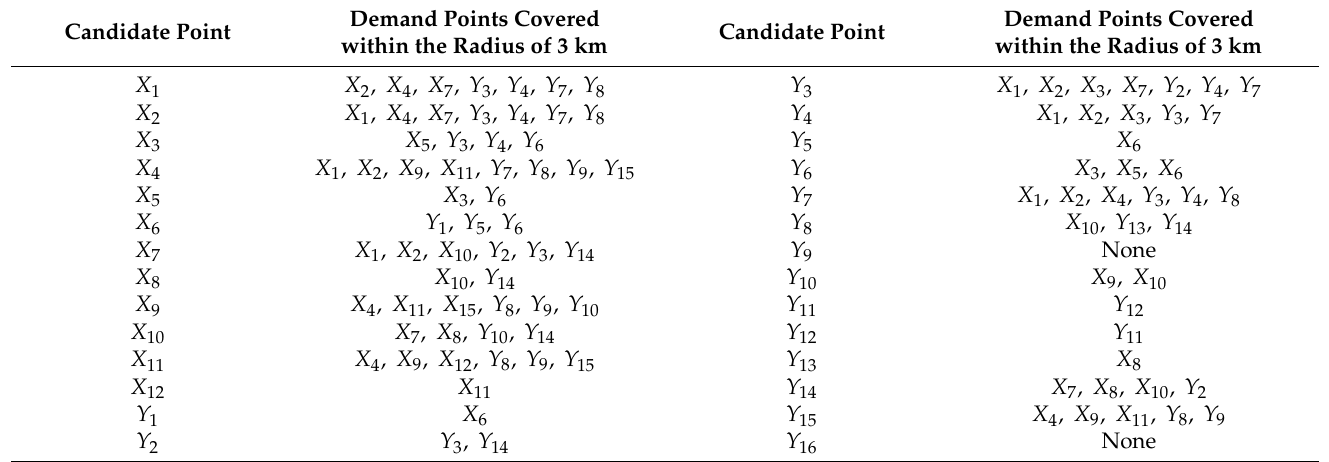
Table 9. Candidate points and their coverage